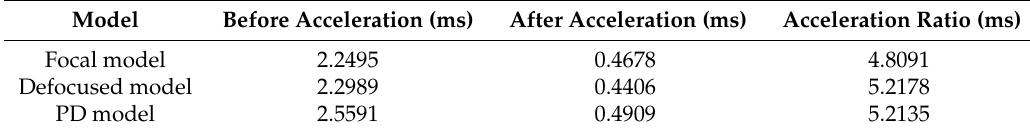
Table 5. The average inference time of PD-CNN models for 3000 samples on 1080Ti.